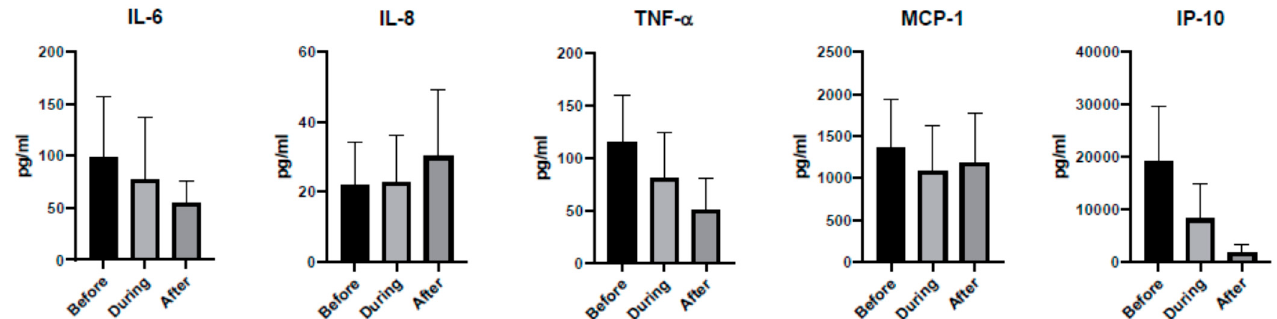
Figure 2. Effect of dexamethasone on cytokine concentrations in COVID-19 patients. Average cytokine values before, during and after dexamethasone treatment are shown as mean with standard deviation. Paired t-tests showed no statistical difference between before and during dexamethasone treatment for any of the cytokines ( p > 0.01, n = 10). Similarly, no significant difference was observed between during and after periods ( p > 0.01, n = 8).